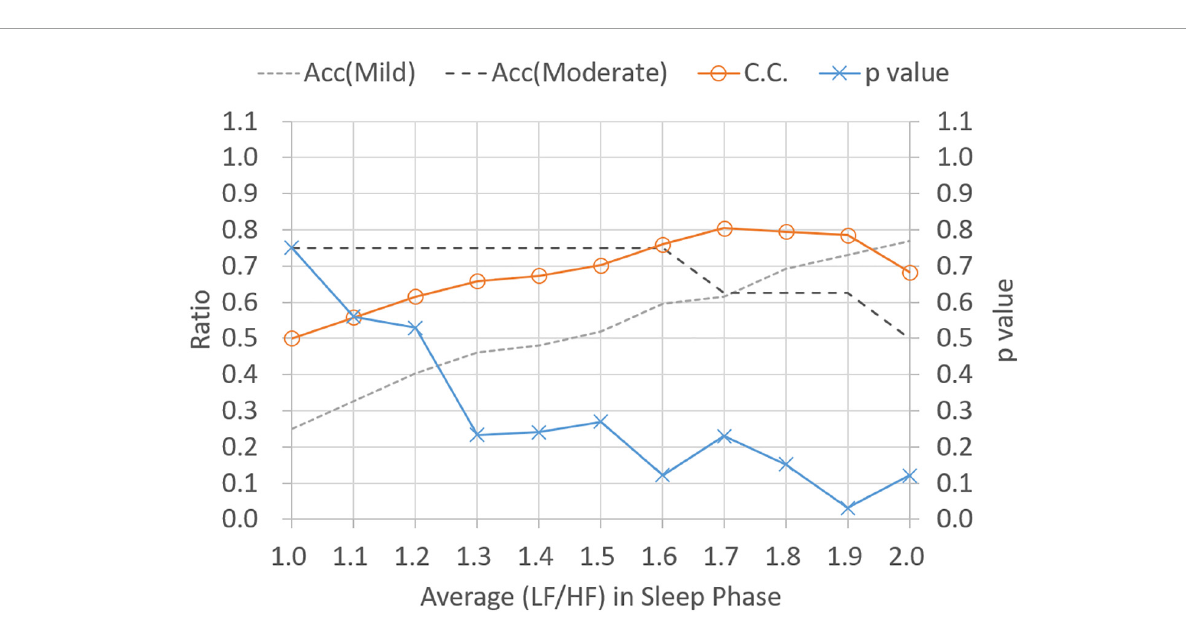
FIGURE6 Classification ratio and p -value obtained from t -test between mild and moderate categories for varied average (LF/HF) ratio in sleeping phase. “Acc” stands for classification